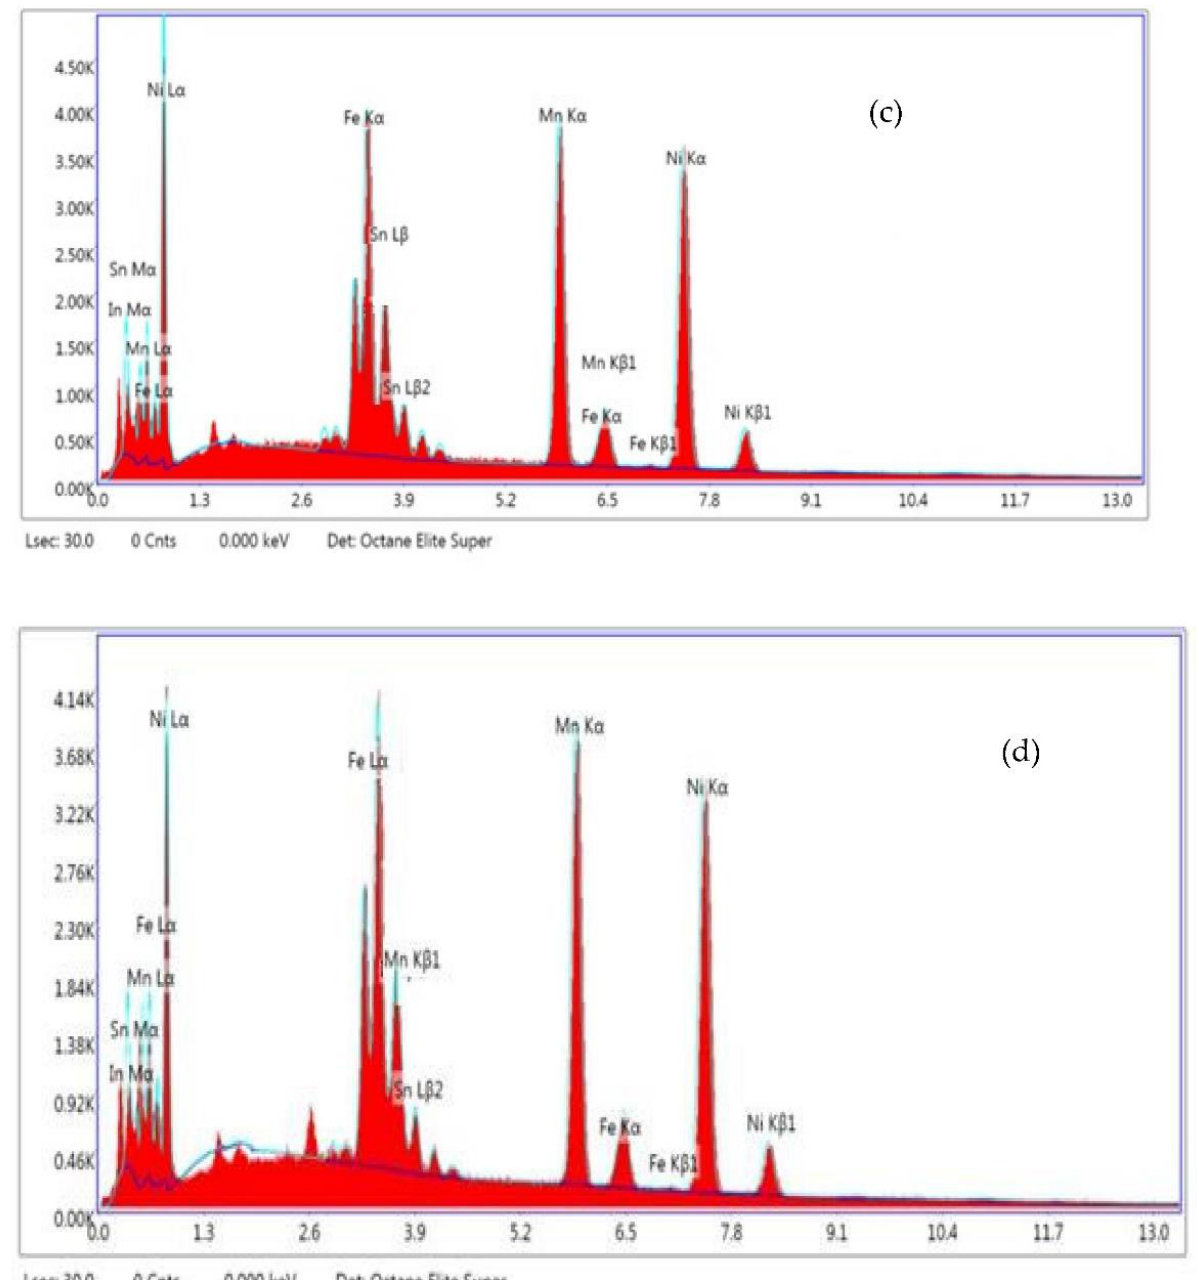
Figure 1. EDS histogram representing the composition of the alloys in Ni 50 − x Fe x Mn 30 Sn 20 − y In y where 1 ≤ x ≤ 4; 2 ≤ y ≤ 8 alloys are represented as ( a – d ), respectively.